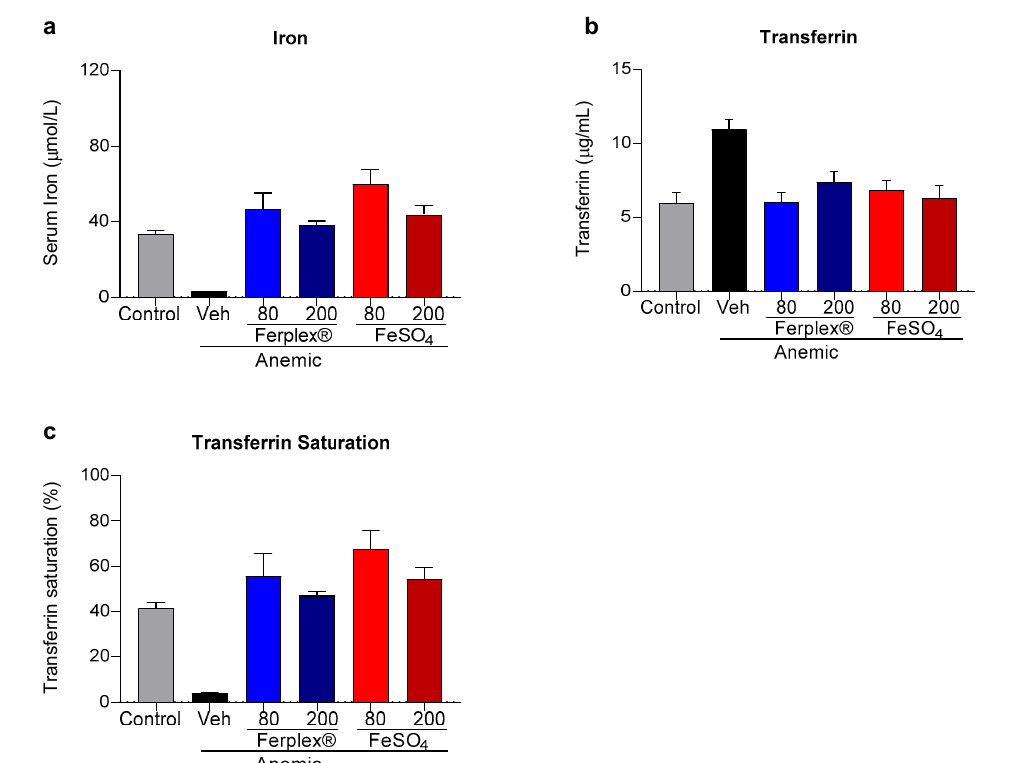
Table 2. Concentration of other biochemical markers on day 15.